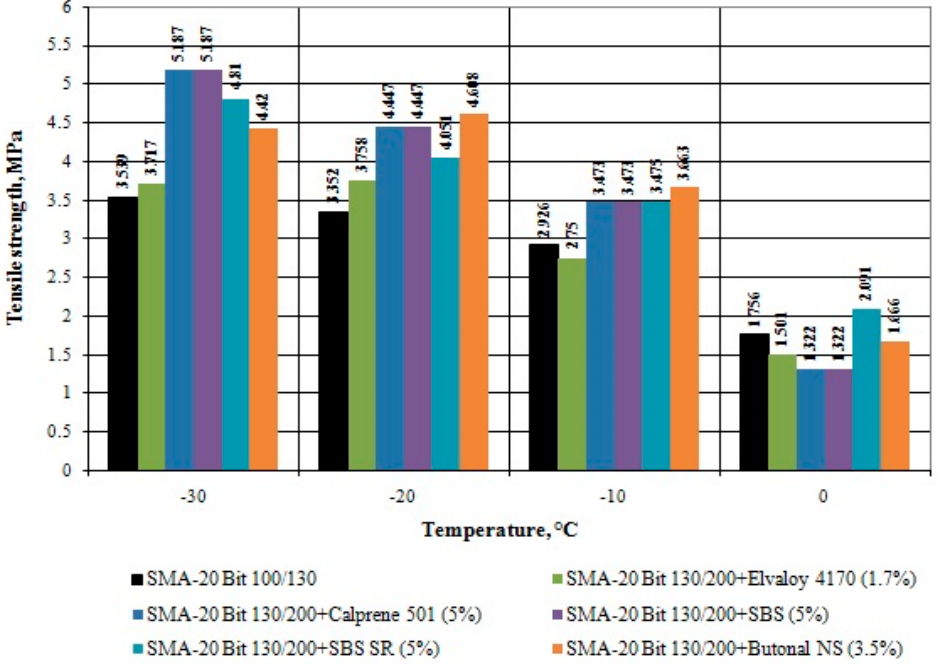
Figure 20. Strength of the stone mastic asphalt concretes after 50 cycles of freezing and thawing at low temperatures.